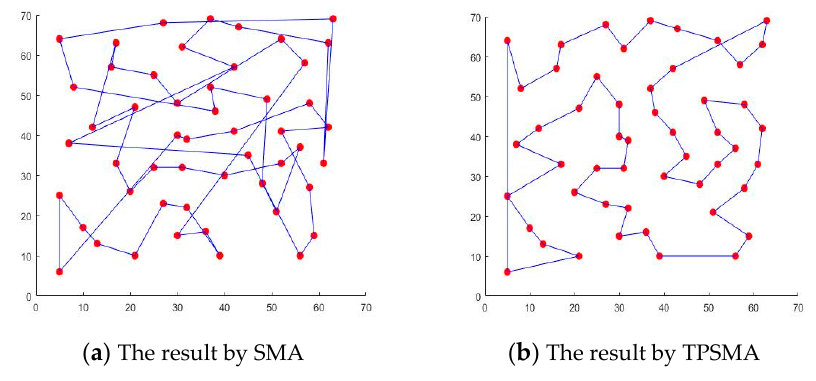
Figure 6. The simulation of city31.